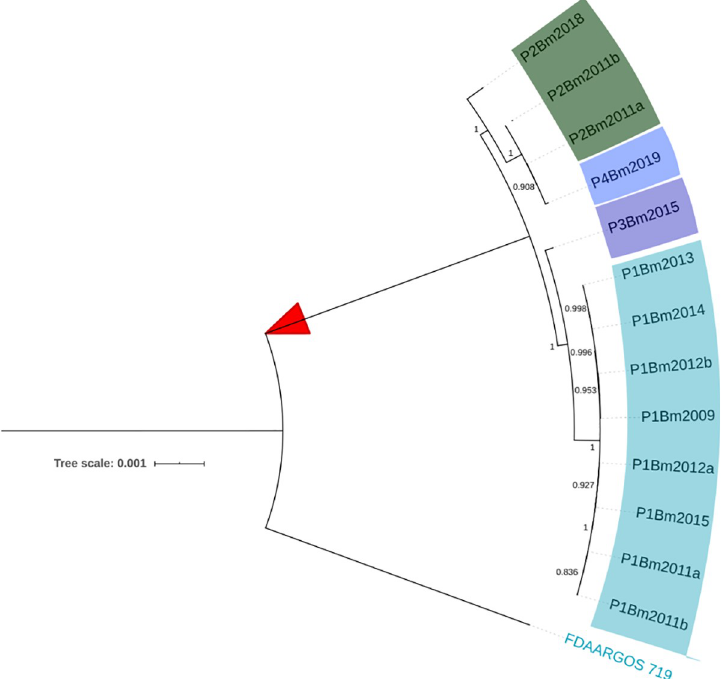
Fig 4. Core-SNP phylogeny of the ST-742 isolates. We used the information contained in the 61,845 core SNPs found between our cluster of ST-742 isolates and the strain FDAARGOS_719 to further zoom in on the evolutionary relations between the ST-742